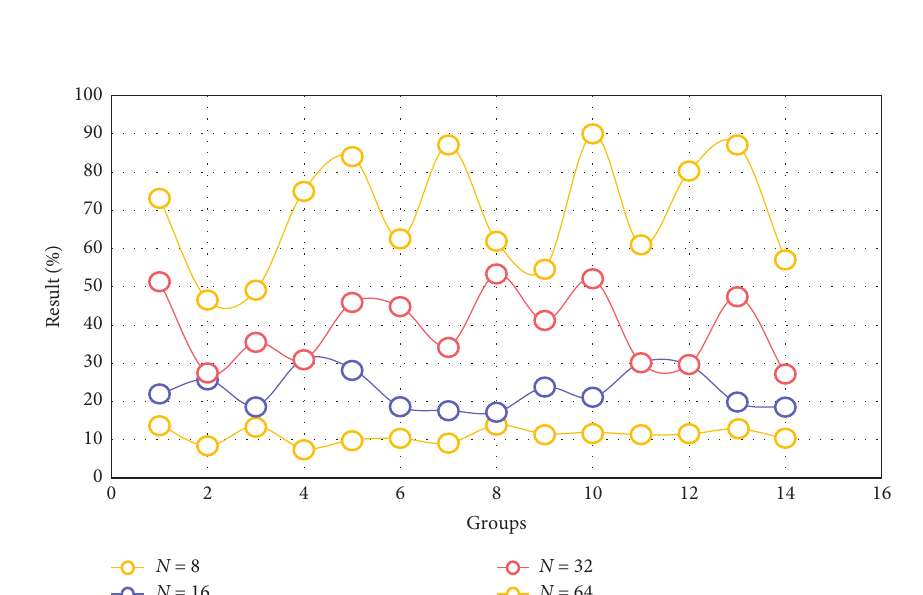
Figure 12: System security results.